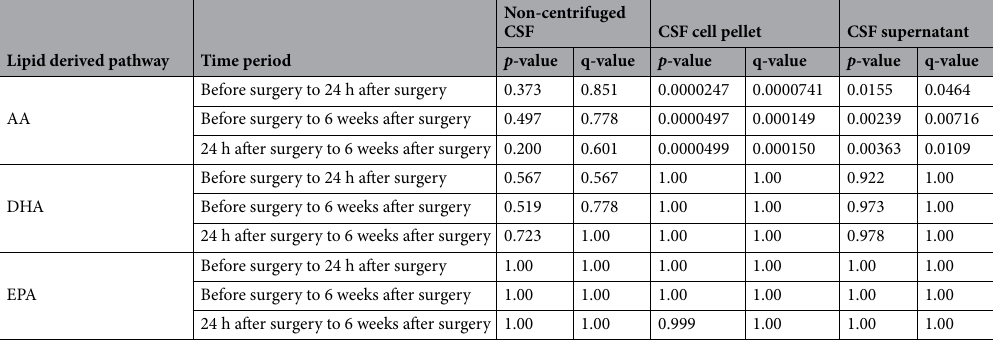
Table 3. GAGE analysis for AA, DHA, and EPA derived metabolite pathway changes over the indicated time periods.